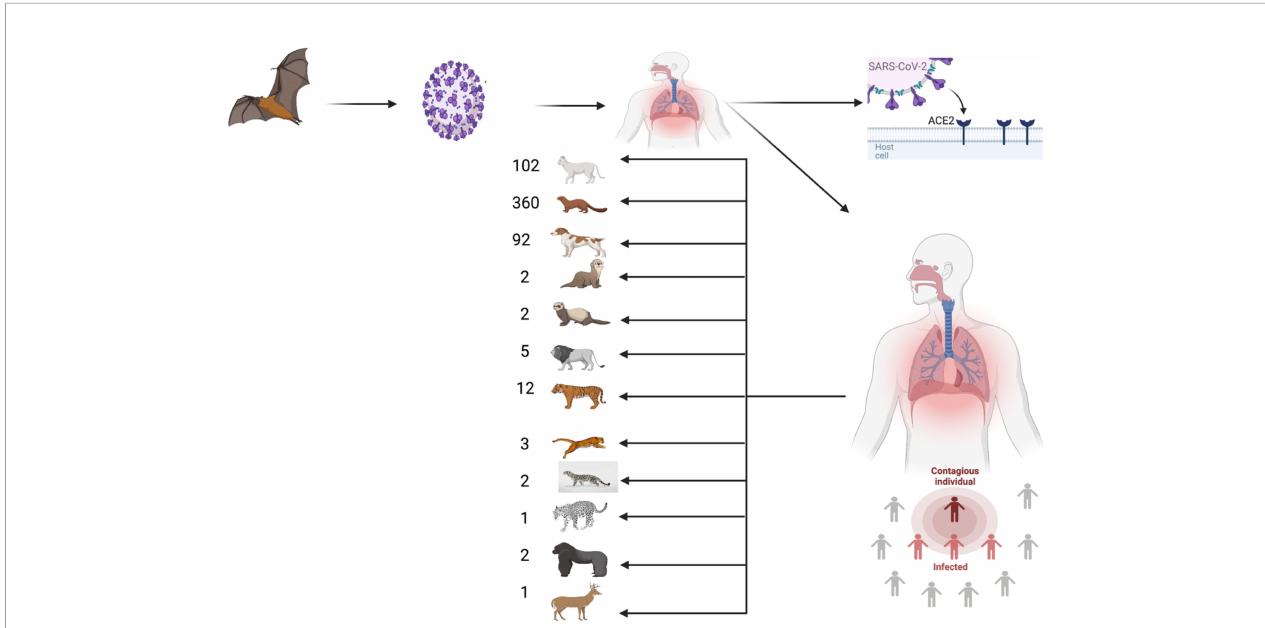
FIGURE 2 | COVID-19 outbreaks in animals. The fi gure illustrates the number of outbreaks reported worldwide by species according to the fi fth OIE report (till 30 September 2021) (OIE, 2021). The fi gure was assembled with Biorender website (Biorender, 2021).